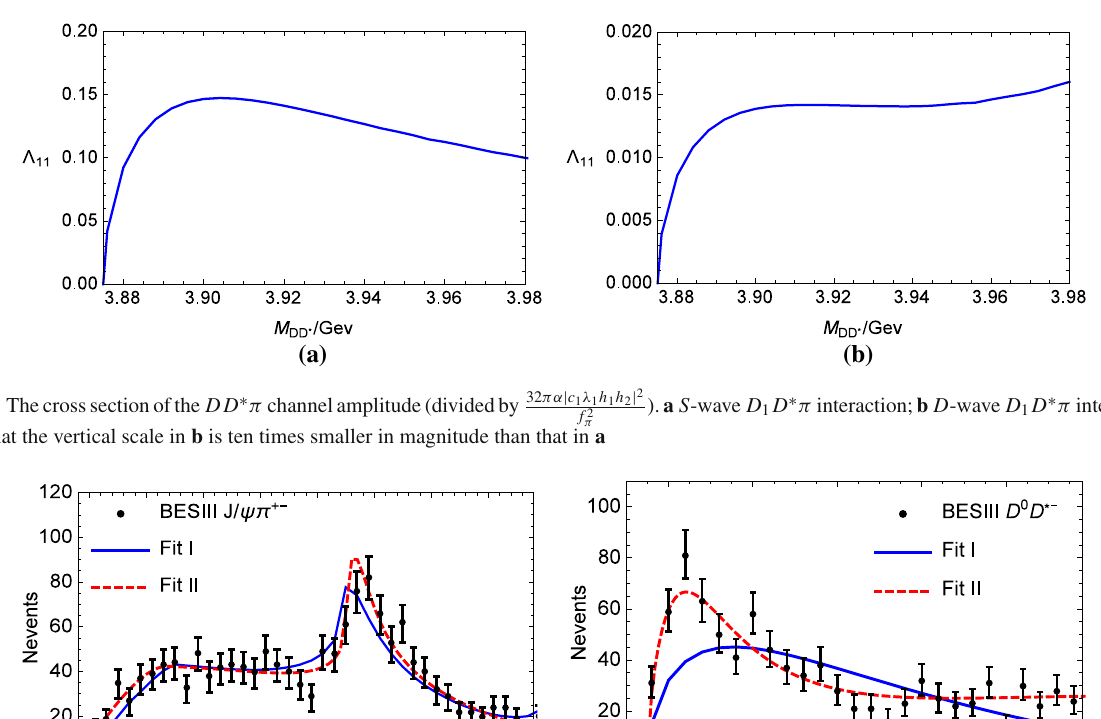
Fig. 9 Data fit using two different parameterizations (Fit I, II) of the amplitudes. a The J /ψπ maximum invariant mass distribution from Ref. [1]; b the D ¯ D ∗ invariant mass distribution from Ref. [4]